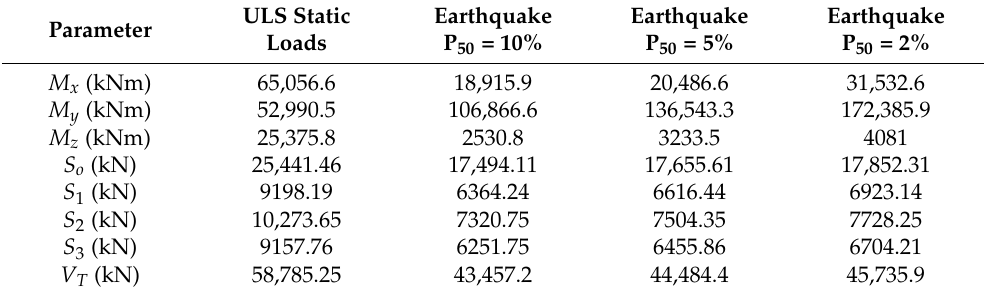
Table 10. Main internal forces at the static ULS (permanent + variable loads) at the seismic ULS (permanent + seismic loads) for the three values of the seismic actions.